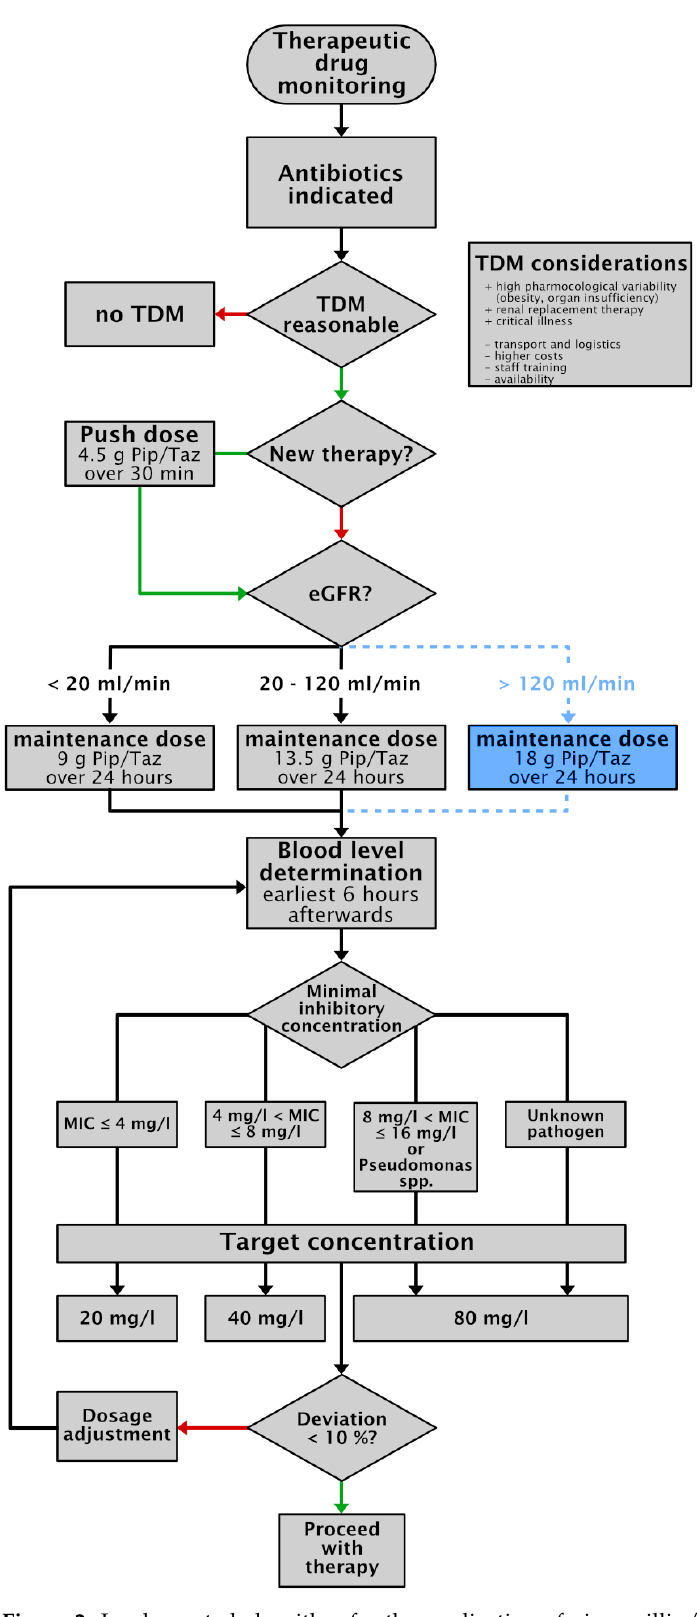
Figure 2. Implemented algorithm for the application of piperacillin/tazobactam and therapeutic drug monitoring of piperacillin at the University Hospital Wuerzburg. Based on the data of this study and the recent literature, we added a potential additional dose regime for critically ill patients with augmented renal clearance, which has to be approved by TDM level evaluation (blue box)